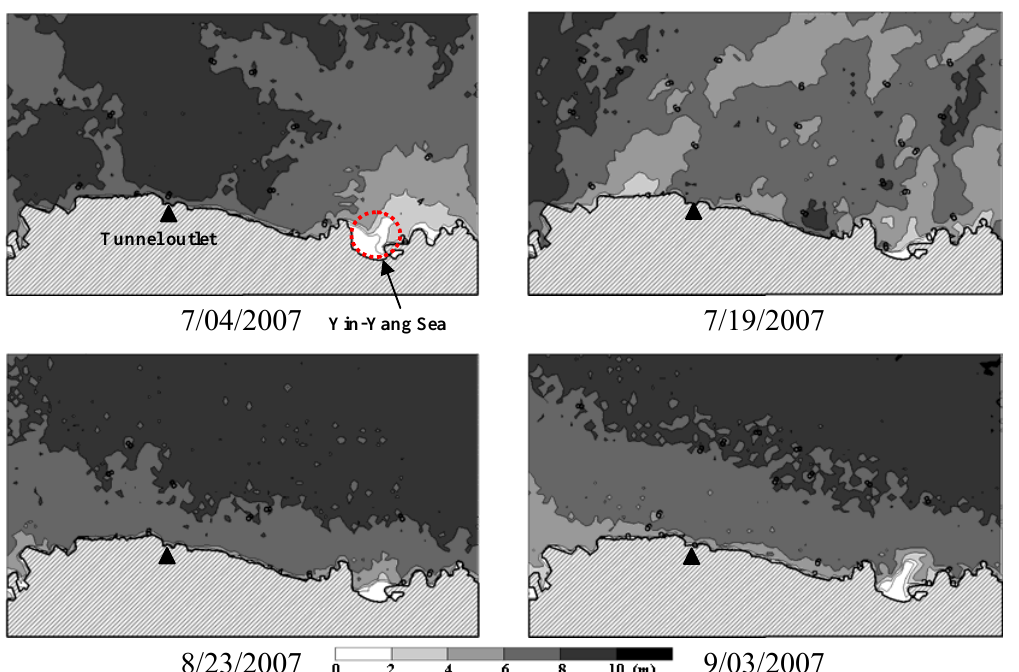
Figure 8. Spatial distribution of secchi disk